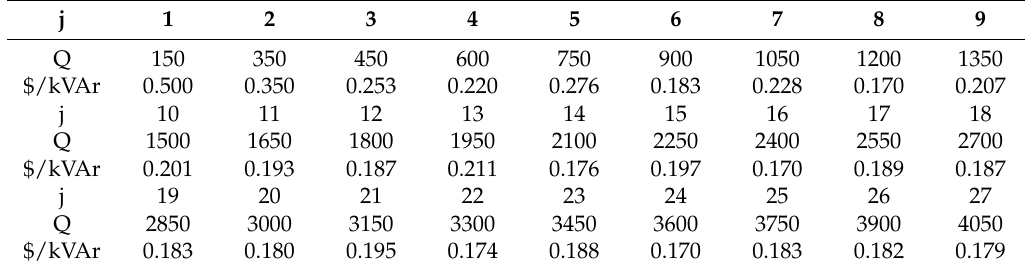
Table 8. Possible capacitor sizes and cost ($/kVAr).